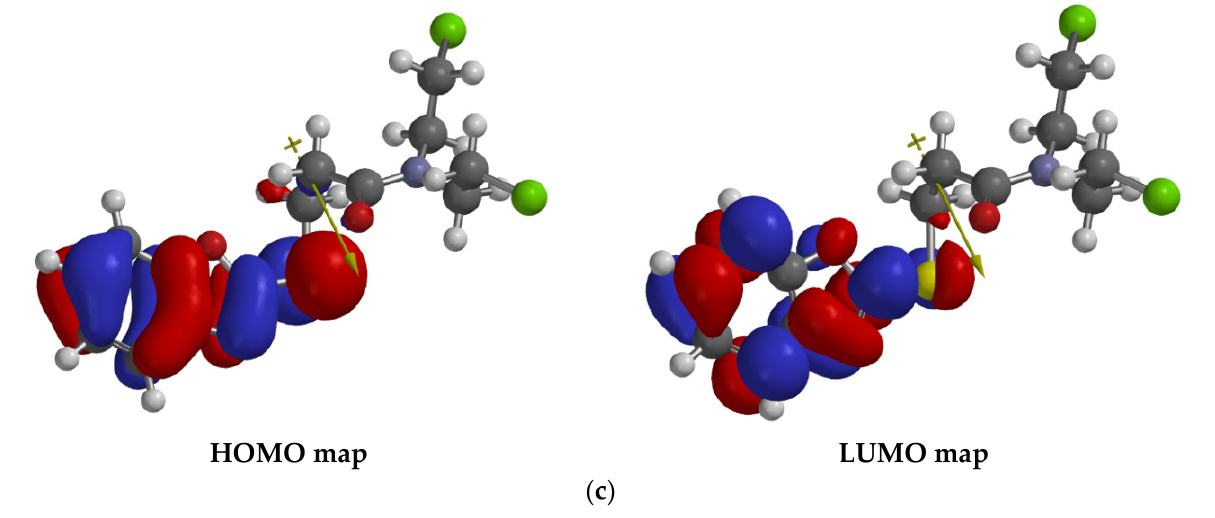
Figure 5. HOMO and LUMO maps of the molecules VIII ( a ), IX ( b ), and X ( c ).